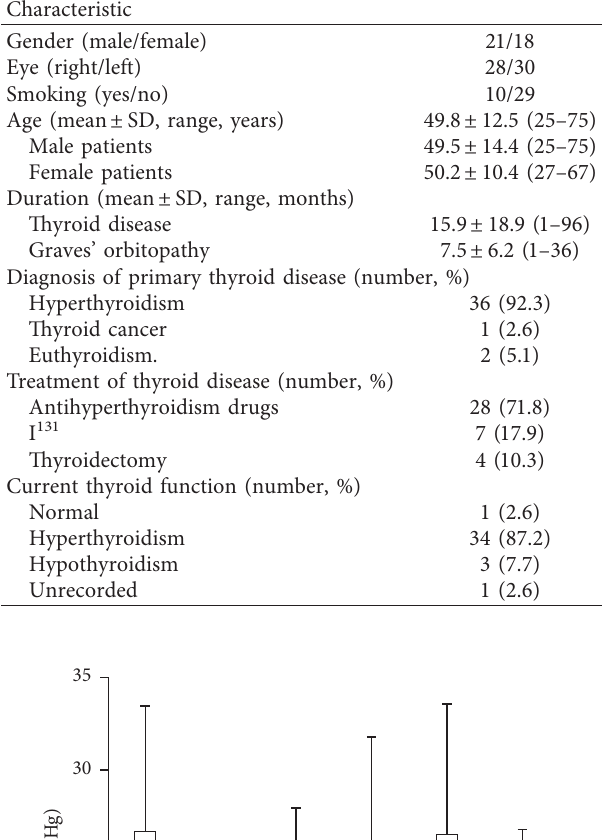
Table 1: Demographic characteristics of elevated intraocular pressure of GO